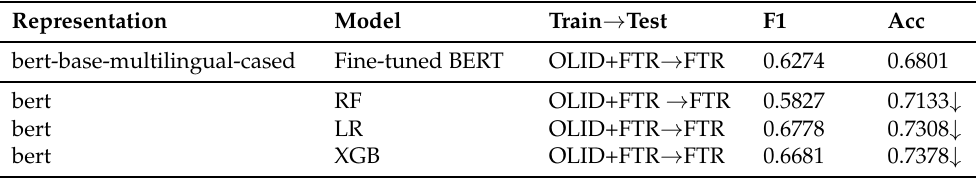
Table 10. Multilingual evaluation results (accuracy and F1).